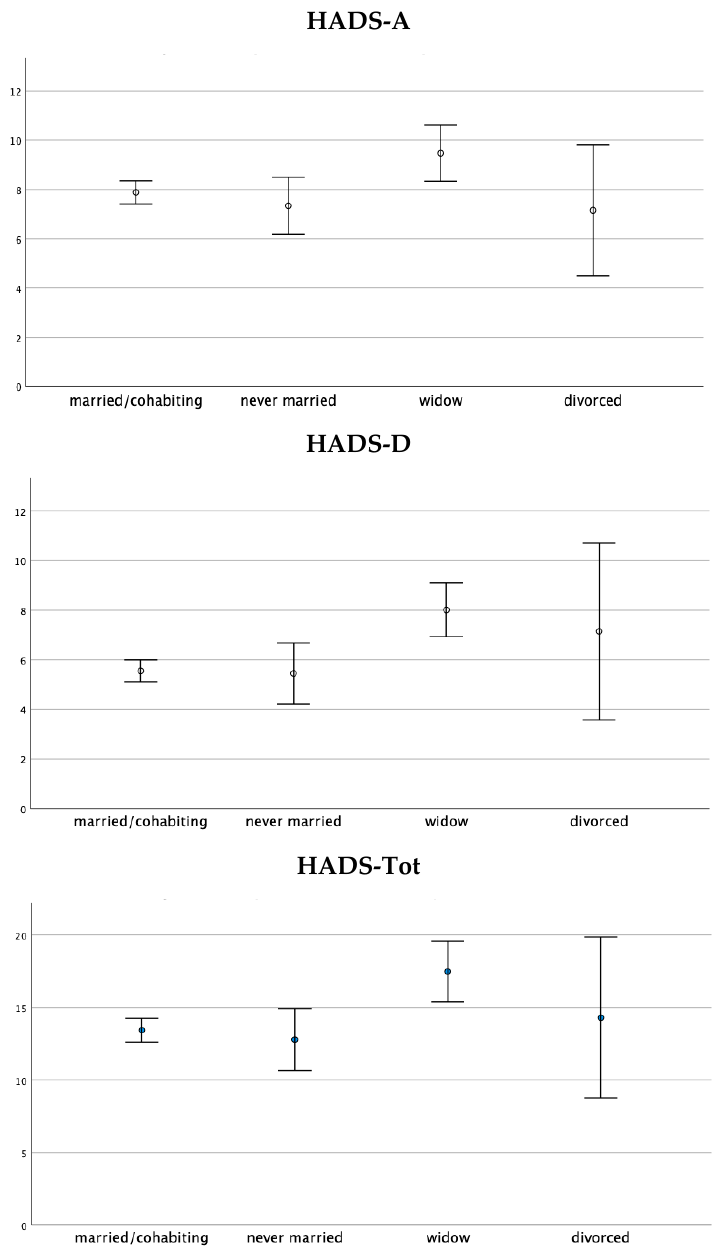
Figure 2. One-way ANOVA on the HADS-A, HADS-D, and HADS-Tot scores with respect to the marital status group. Note: Data are presented as the mean ± standard deviation. The HADS-A, HADS-D, and HADS-Tot scores were significantly different between the marital status groups (respectively, F(3, 419) = 3.258, p < 0.05; F(3, 419) = 6.657, p < 0.01; and F(3, 419) = 5.381, p < 0.01). The 𝑋 2 test showed a significant association between the level of education and the presence/absence of clinically relevant anxious symptoms (scores ≥ HADS-A cut-off) ( X 2 = 11.792, p = 0.008). In detail, in the “middle school diploma” level of education category, the frequency of patients above the cut-off for HADS-A was higher than those expected in the case of a non-significant association (HADS-A: Adjusted residue: +2.6, 47.30%, n = 167). Therefore, the frequency of patients with a middle school level of education with clinically relevant anxious symptoms was higher than those with a primary school di- ploma (44.15%, n = 34), high school diploma (34.61%, n = 63), and with a degree (25%, n =